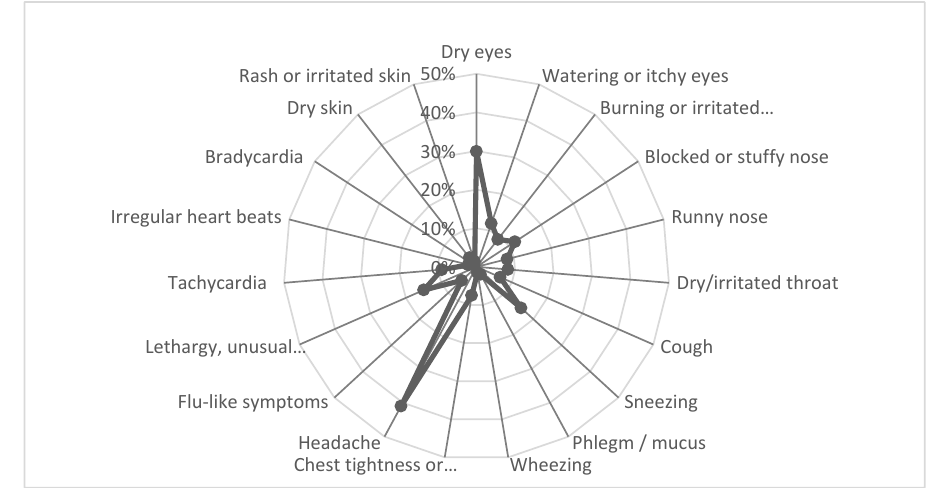
Figure 4. SBS Symptoms prevalence